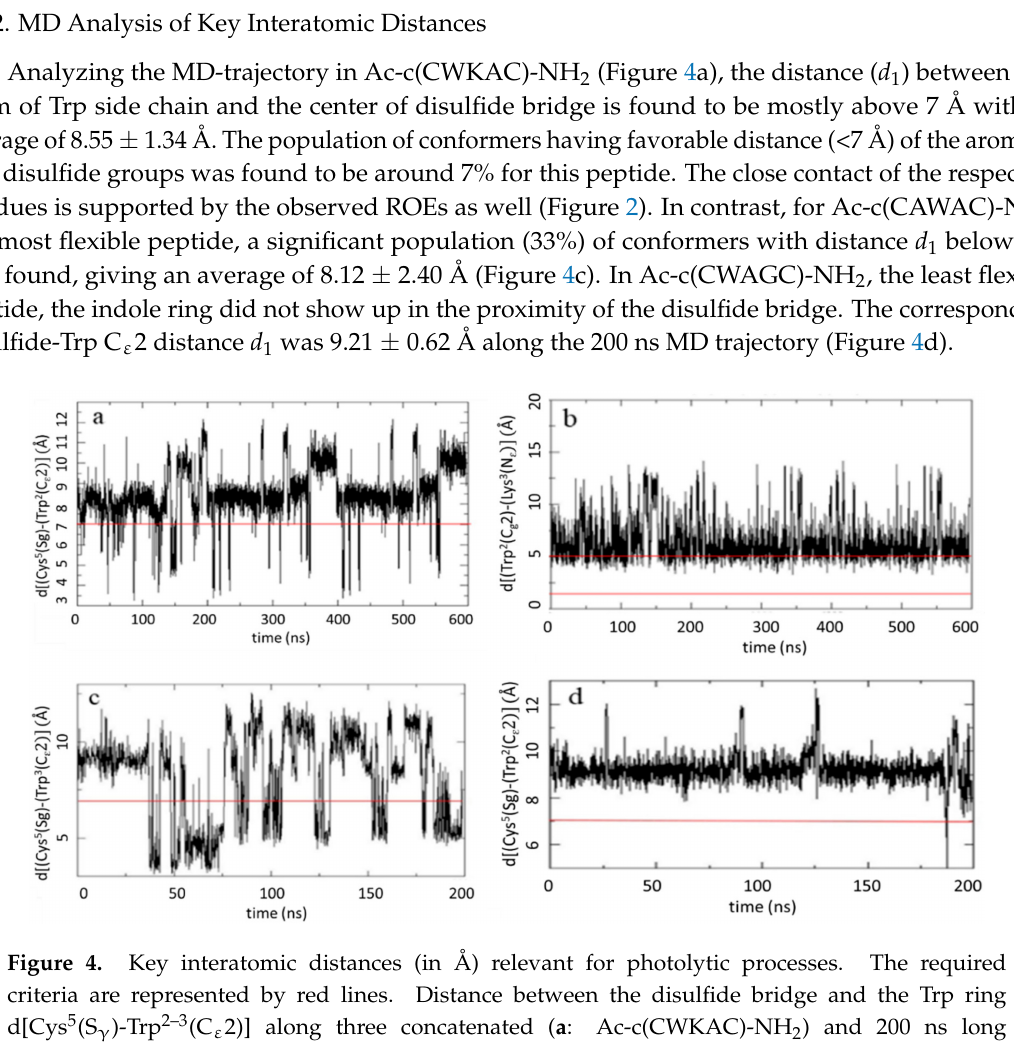
Figure 3. ROE-based structural ensembles. ( a ): Ac-c(CWKAC)-NH 2 , ( b ): Ac-c(CAWAC)-NH 2 and ( c ): Ac-c(CWAGC)-NH 2 . The starting structures for MD refinement were extracted from these NMR ensembles as described in the experimental and the supplementary section (Table S2).